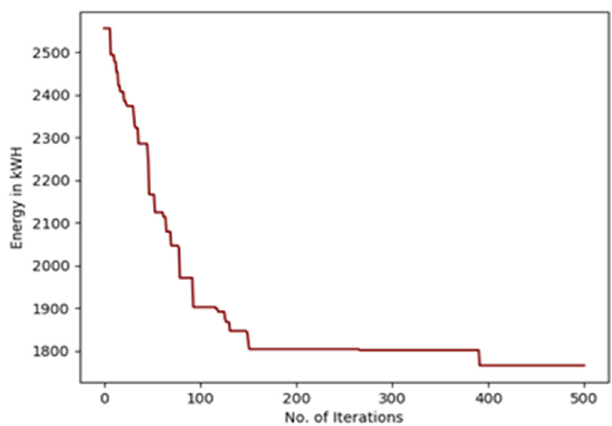
Figure 4. Total energy consumed by the three trucks (PSO).